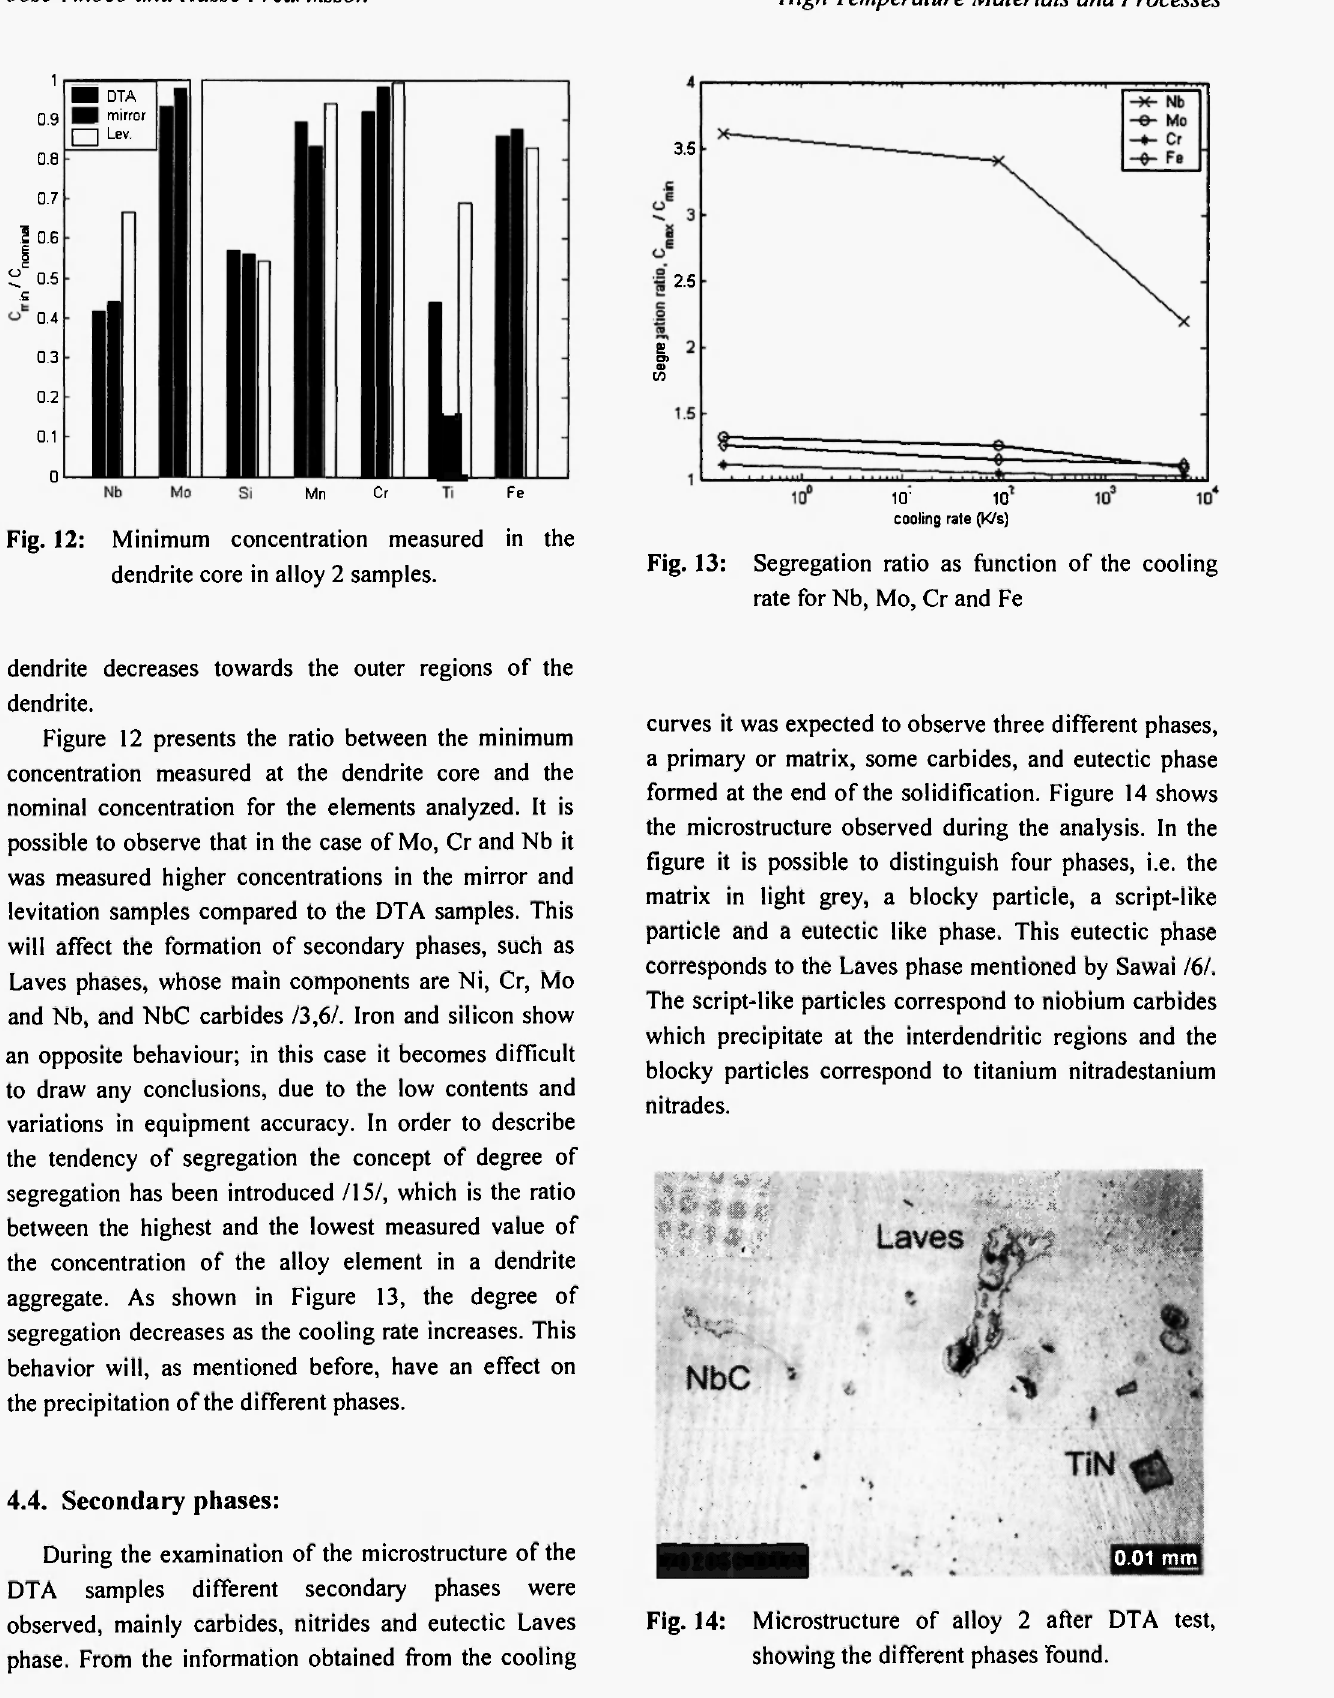
Fig. 14: Microstructure of alloy 2 after DTA test, showing the different phases